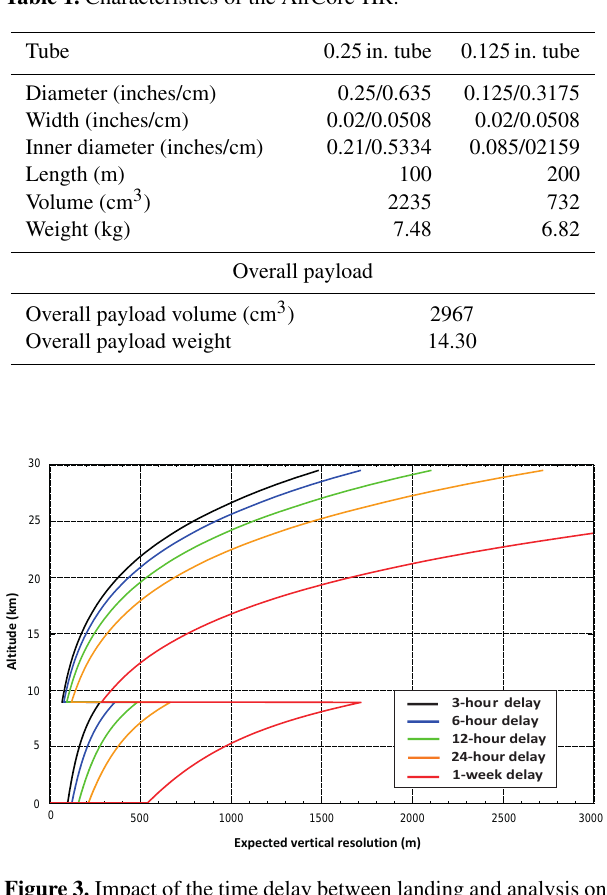
Figure 3. Impact of the time delay between landing and analysis on the expected vertical resolution of AirCore-HR, for a storage time of 3h (black), 6h (blue) and 12h (green), 24h (orange) and 1 week